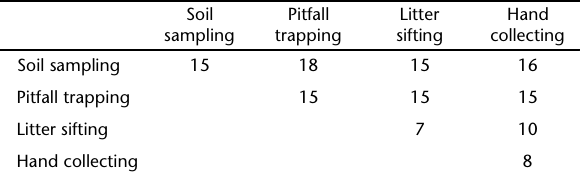
Table 2. Numbers of species recorded by individual methods and by combinations of two methods.